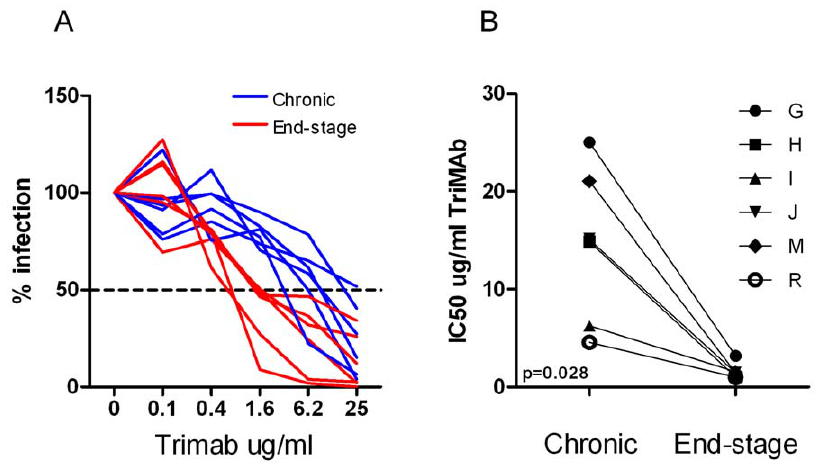
Figure 1. Sensitivity of sequential chronic and end-stage R5 viruses to neutralization by TriMAb. a) Percent TriMAb neutralization of chronic stage R5 isolates (blue lines) and end-stage R5 isolates (red lines), b) TriMAb IC50 of chronic and end-stage R5 isolates.